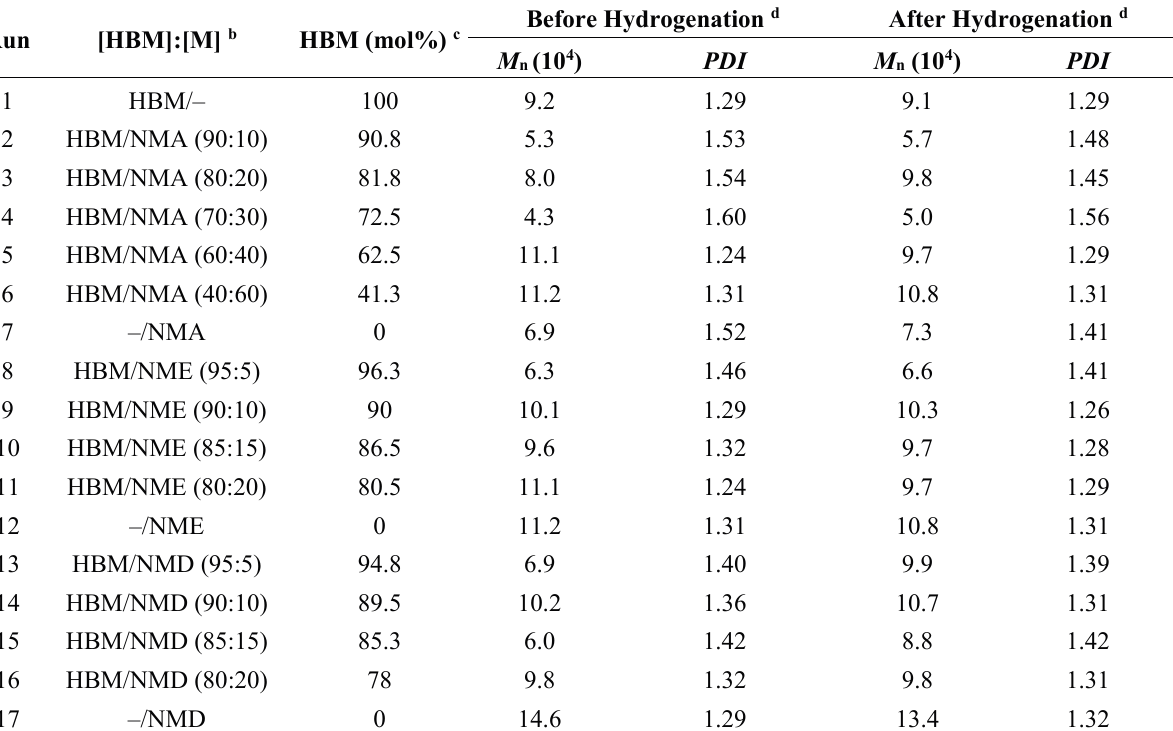
Table 1. ROMP (ring-opening metathesis polymerization) of HBM with comonomers by Catalyst G1 a